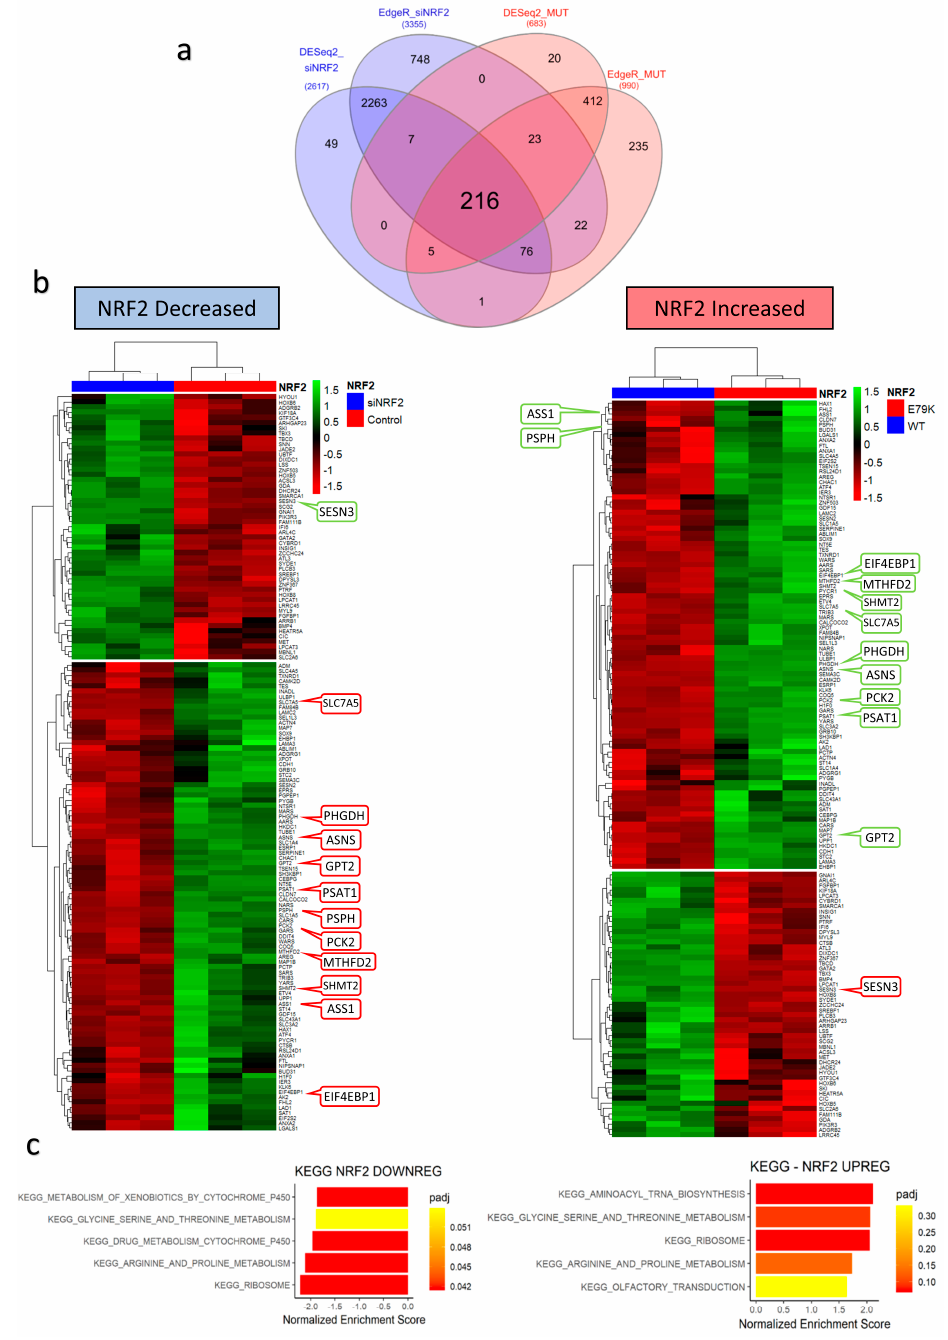
Figure 3. Changes in NRF2 signalling alternatively regulates a conserved group of genes responsible for metabolic processes. ( a ) Venn diagram showing the shared group of genes in different states of NRF2 activation; ( b ) heatmaps of relative change in expression (z-score) of shared genes, with key metabolic genes highlighted; ( c ) GSEA KEGG pathway analysis of conserved group of shared genes demonstrating significant enrichment for amino acid and protein